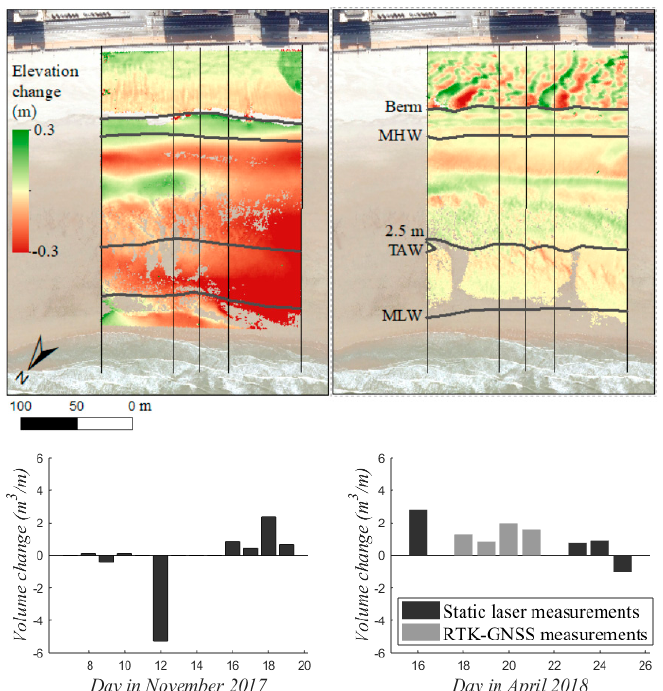
Figure 9. DoD of the first and last survey (top) and daily volume changes of the intertidal zone (MLW – toe of the berm; bottom) for the November (left) and April (right). Measurements are lacking for 7, 11, 13–15 November and 17 April.